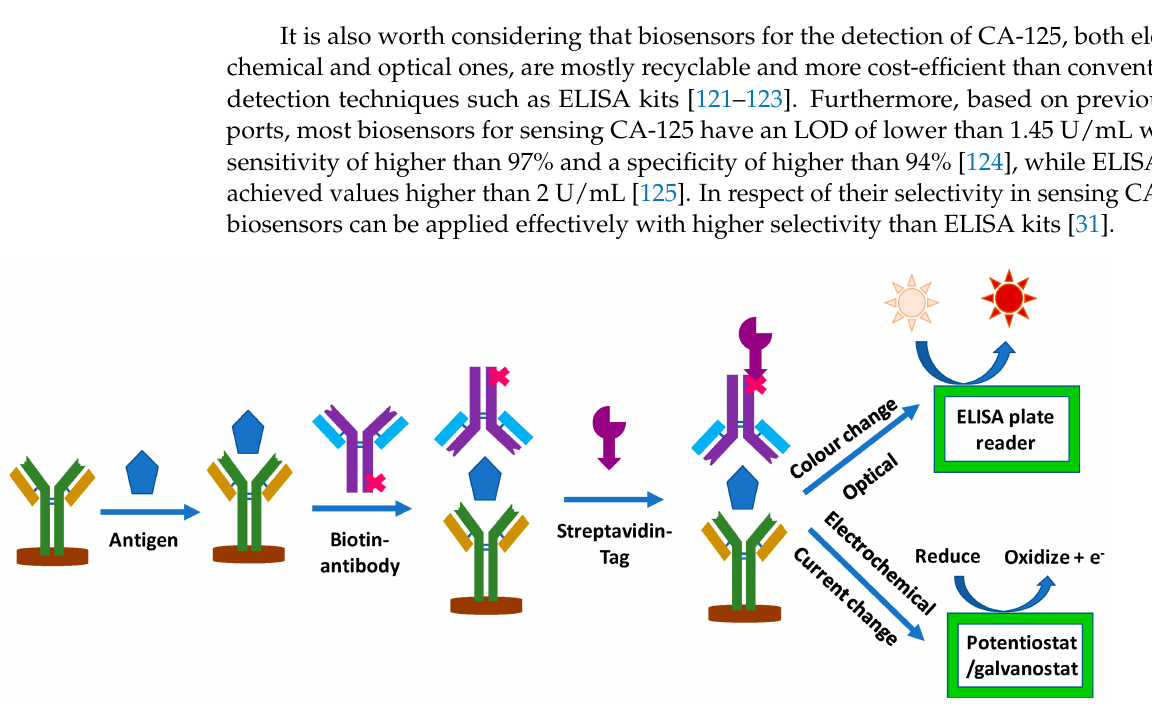
Figure 6. Schematic of immunosensor operating and detection mechanism